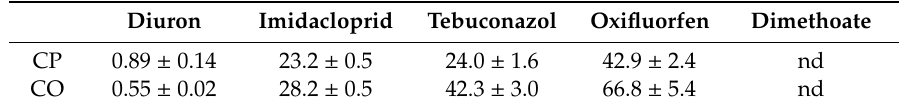
Table 1. Concentration (mg kg − 1 ) of pesticide residues remaining in the two biomixtures. Values (dry mass) are means ± SD (n =